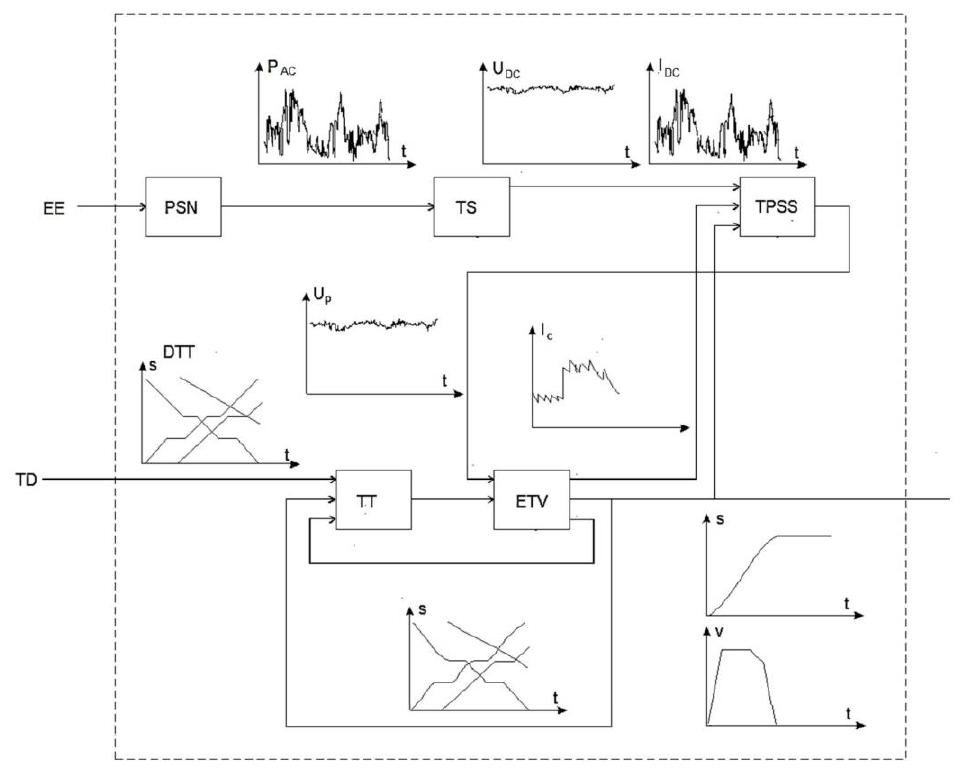
Figure 2. Functional scheme of ETS system after decomposition into subsystems and presentation of exemplary time runs of input and output values (EE — electrical energy, TT — timetable, DTT — demanded timetable, RTT — actual (resulted timetable), TD — transport demand, T — transport output, I C — ETV current, Up-voltage in a catenary, I DC — TS current, U DC — voltage at TS busbar, P AC — power taken by TS from PSN), s — position of a train, v — speed, t — time (based on [47]).